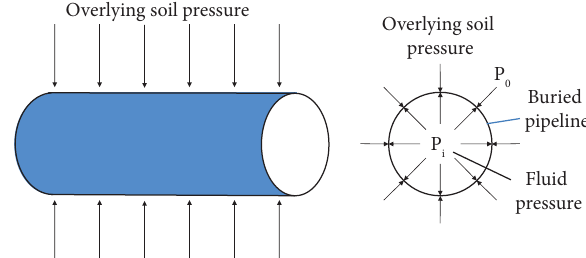
Figure 5: Schematic diagram of force at a cross section for buried PE pipelines